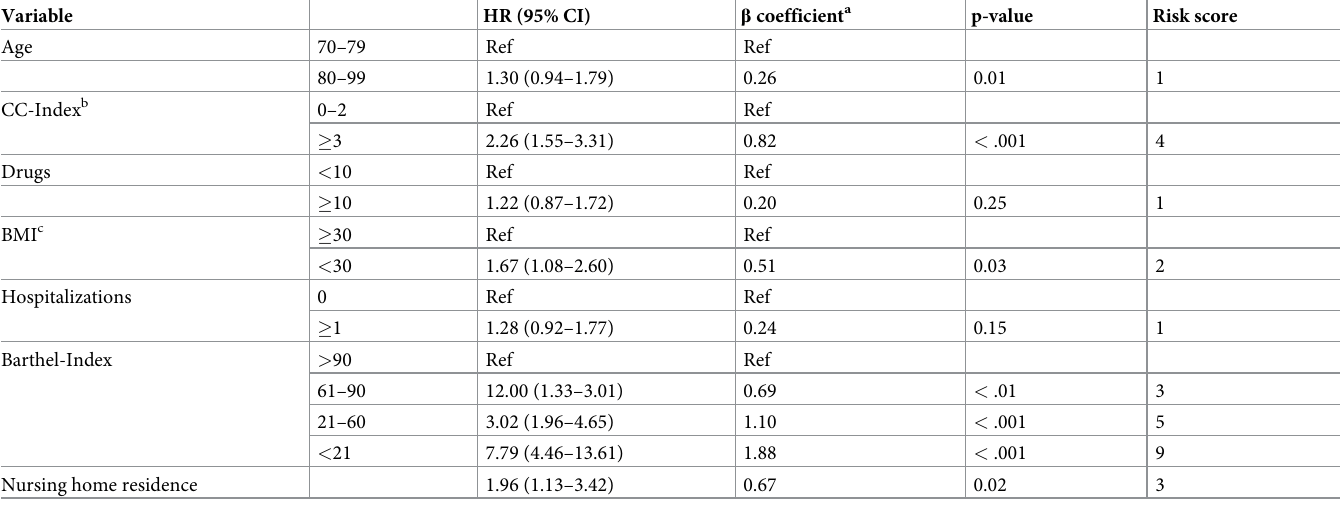
Table 2. 1-year mortality predictors retained in the final model and associated risk score.